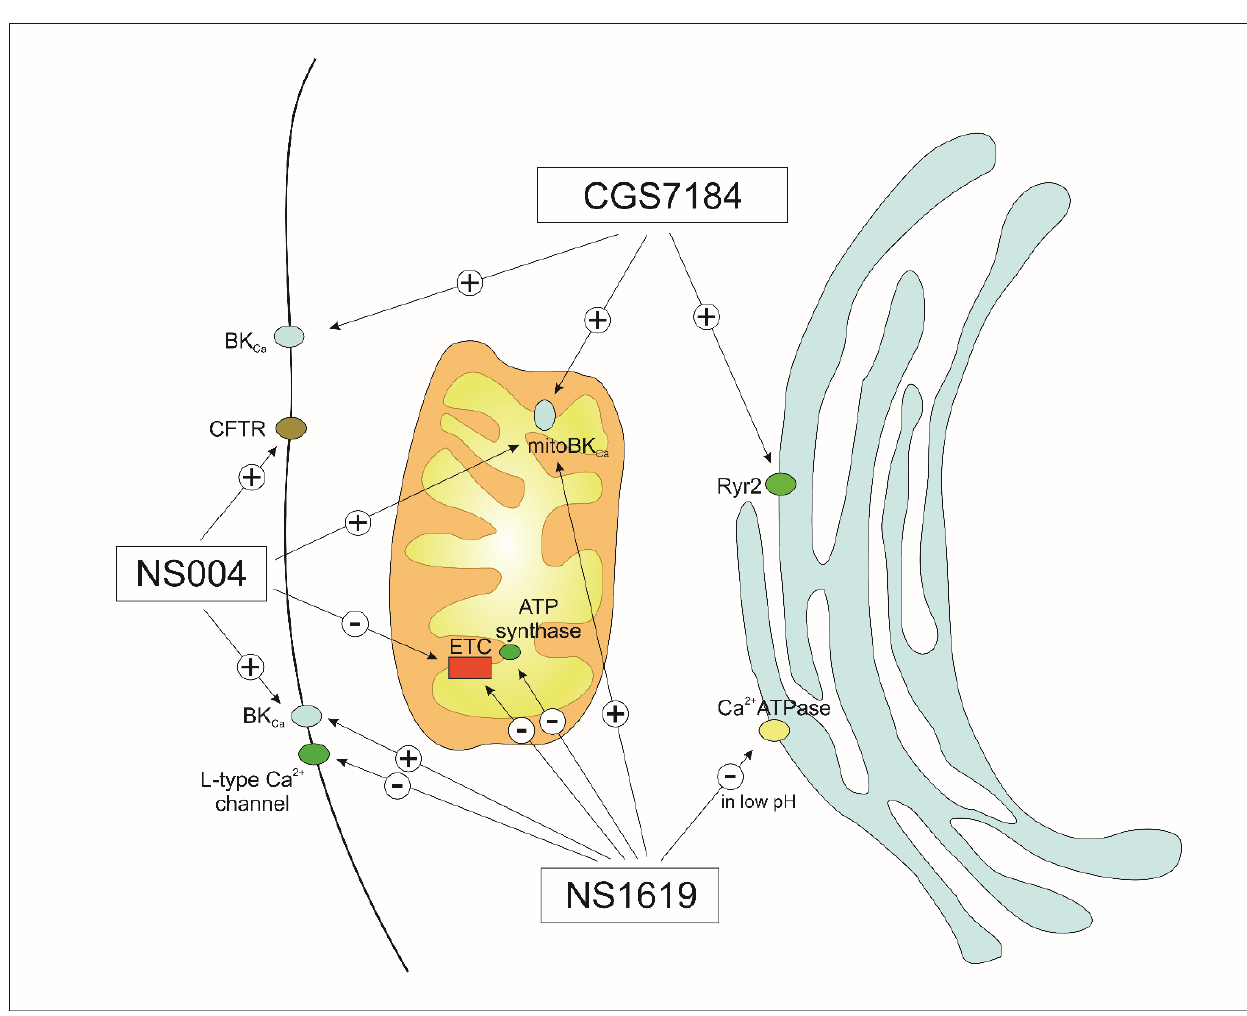
Figure 2. Scheme of the targets of mitoBK Ca openers NS1619, NS004, and CGS7184. The targets located in mitochondria, endoplasmic reticulum, and plasma membrane are shown. “+”—activation, “-“—inhibition.